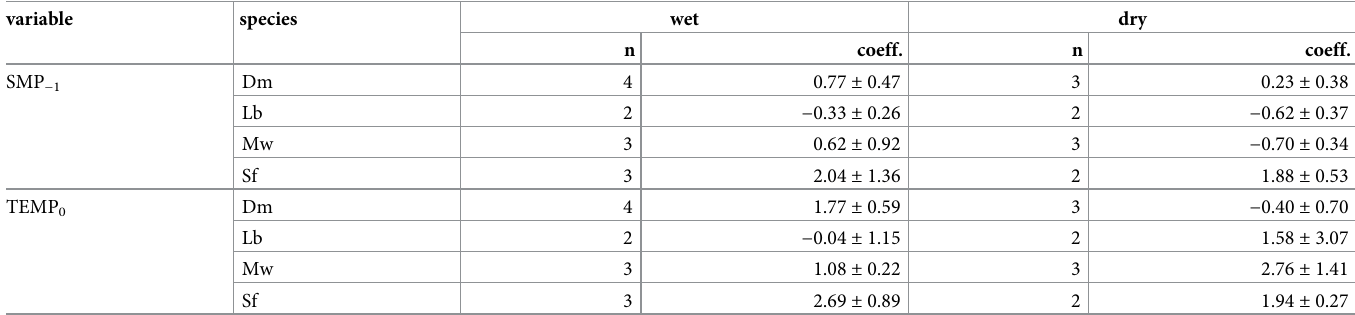
Table 4. Mean adjusted coefficients for Dimorphocalyx muricatus (Dm) and Mallotus wrayi (Mw) from the time-series GLS regressions of 1-day girth increment ( gthi ) on soil moisture potential lagged by 1 day (SMP − 1 ) and unlagged ambient temperature (TEMP 0 ), in the wet and dry periods. Individual tree values are plotted in Fig 7 which displays the species’